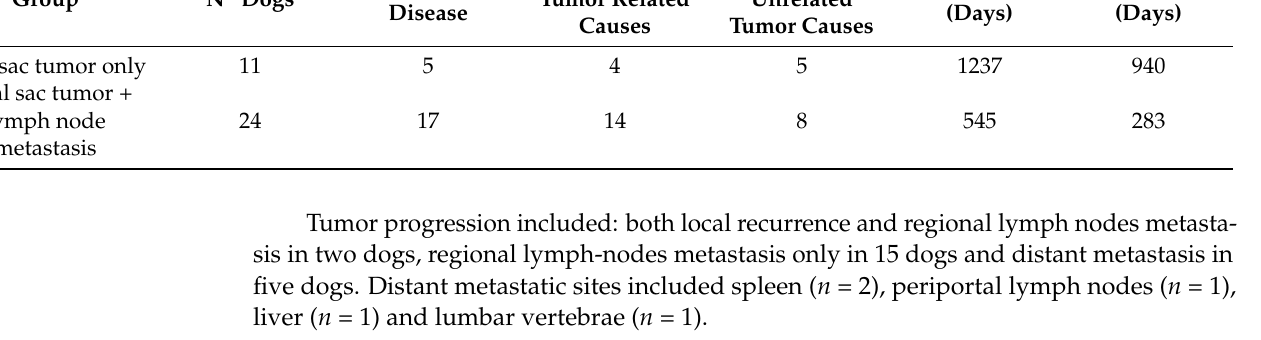
Table 2. Oncologic outcome of the 35 dogs included in the study. Two groups were considered: dogs with primary tumor only ( n = 11) and dogs with both primary tumor and metastatic regional lymph nodes ( n = 24). Death for Death for Progressive Median ST Median DFI Group N ◦ Dogs Tumor Related Unrelated Disease (Days) (Days) Causes Tumor Causes Anal sac tumor only 11 5 4 5 1237 940 Anal sac tumor + lymph node 24 17 14 8 545 metastasis